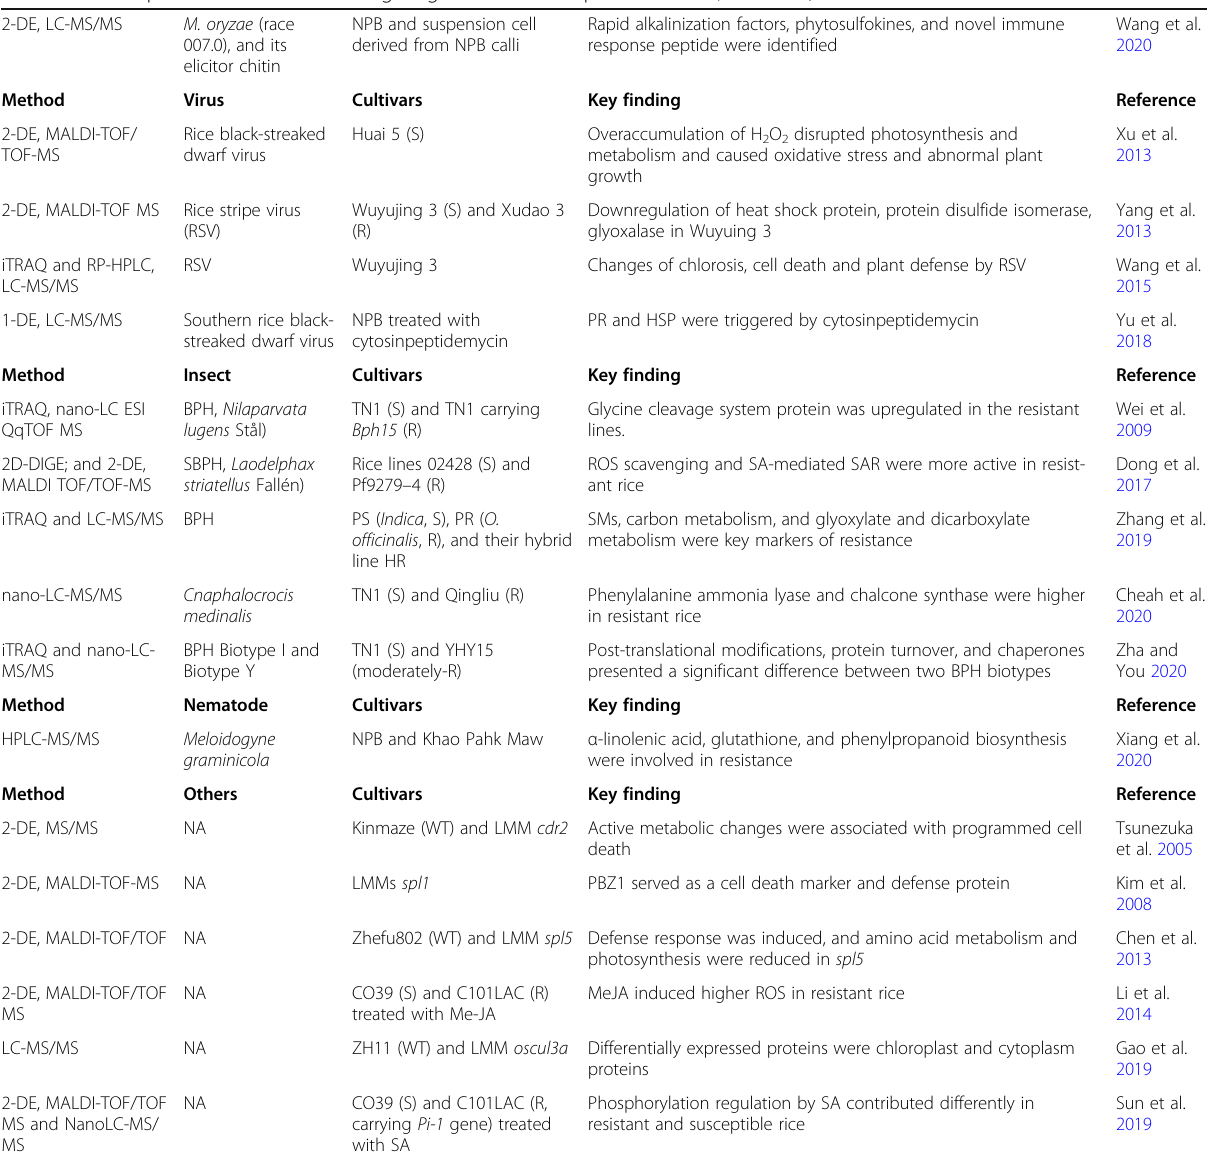
Table 1 Global proteomics studies investigating biotic stress responses in rice